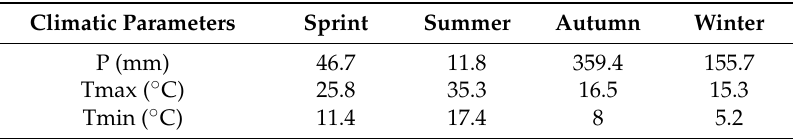
Table 3. Values for the population selected for sample collection: P: total seasonal rainfall (mm); Tmax: mean of the seasonal maximum temperatures ( ˝ C); Tmin: mean of the minimum seasonal temperatures ( ˝ C). Climatic Parameters Sprint Summer Autumn